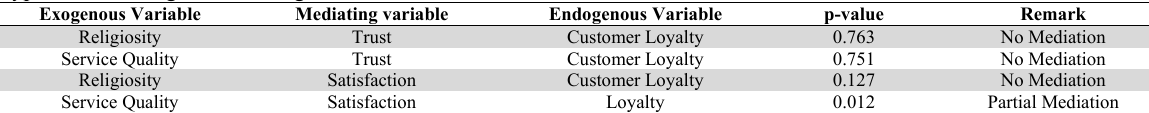
Hypothesis Testing of Mediating